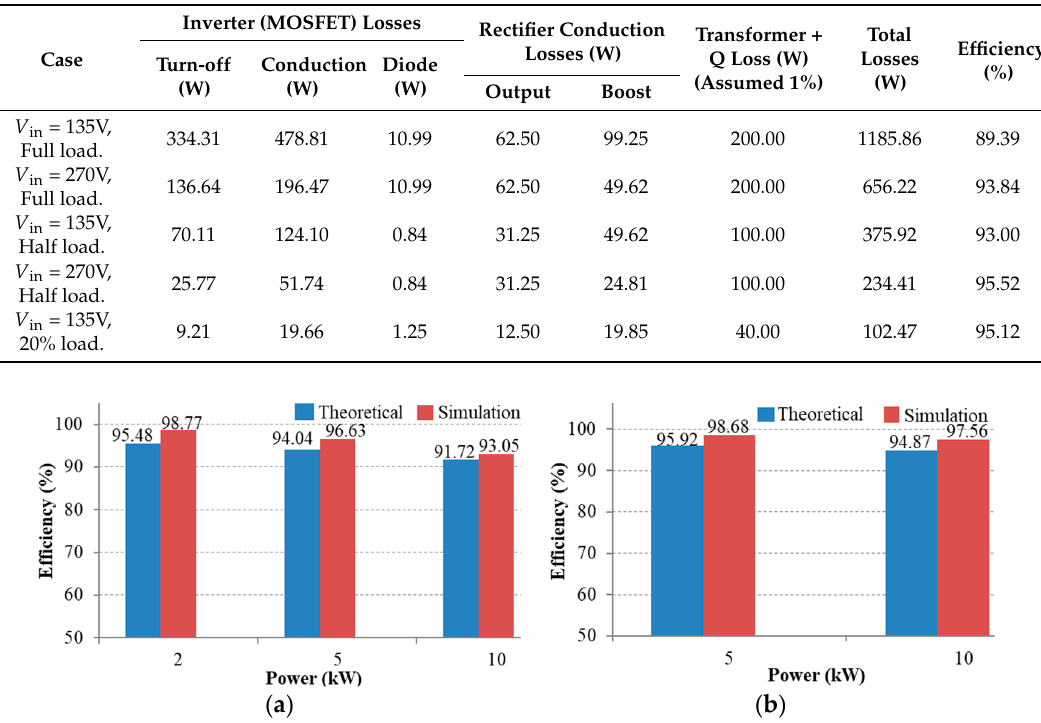
Figure 16. Theoretical and simulation efficiencies:( a ) V in (min) = 135 V full load (10 kW), half load